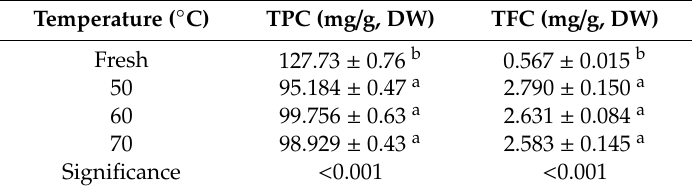
Table 6. Total phenolic and flavonoids content of the fresh and dried linden